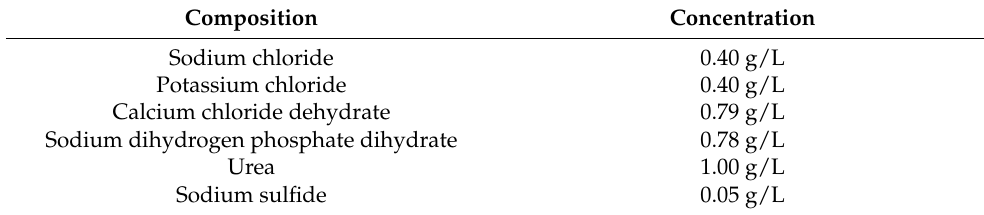
Table 1. Main composition of artificial saliva according to the manufacturer. Composition Concentration Sodium chloride Potassium